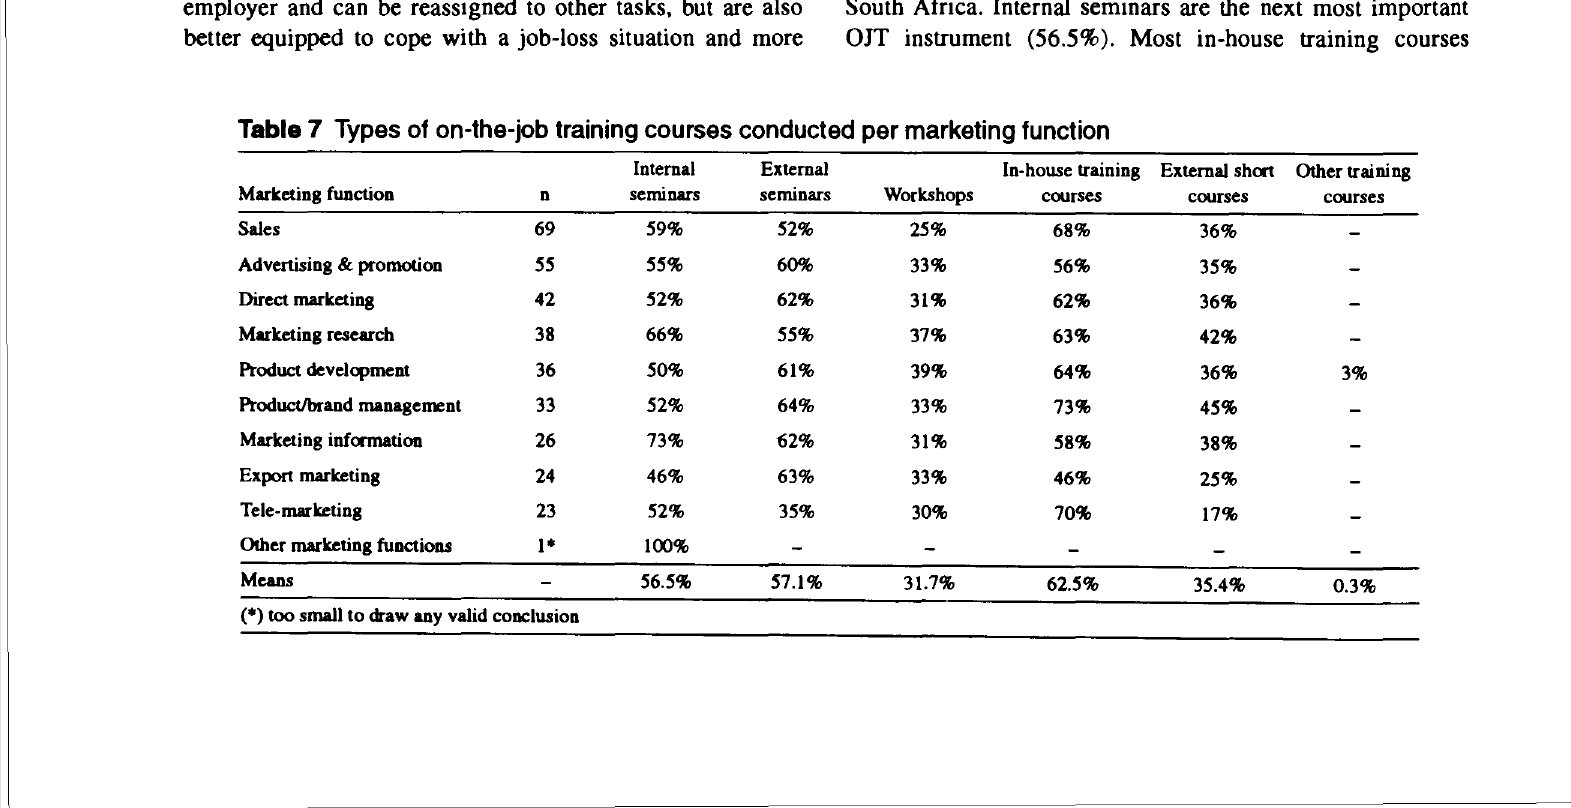
Table 7 Types of on-the-job training courses conducted per marketing